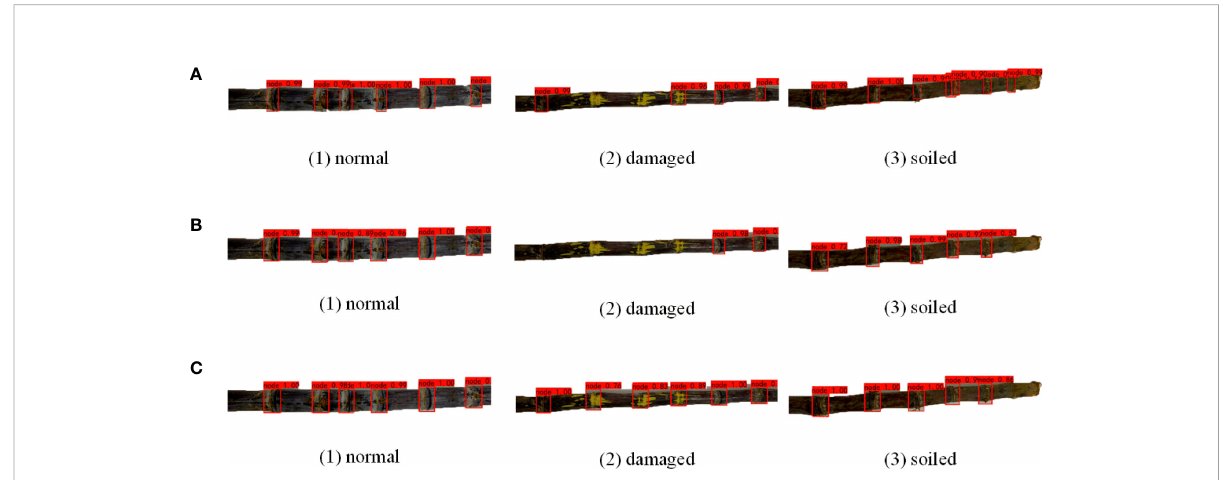
FIGURE 8 Sugarcane target recognition under different models. (A) Faster RCNN (B) YOLOv4 (C) Enhanced